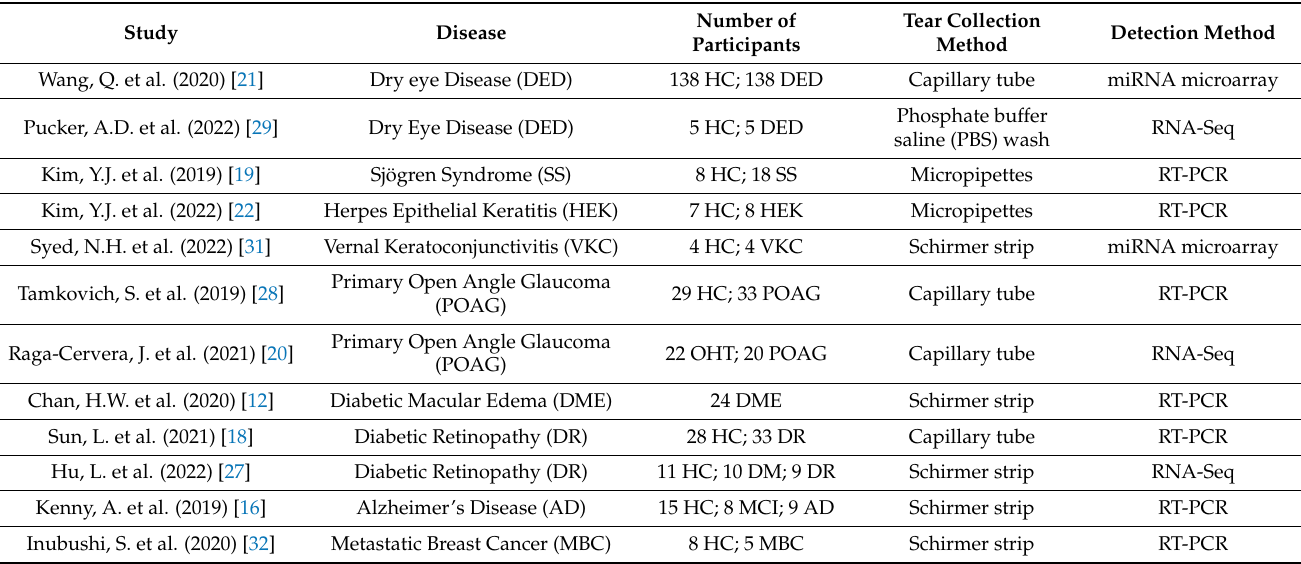
Table 1. Summary of literature reporting tear microRNAs as potential